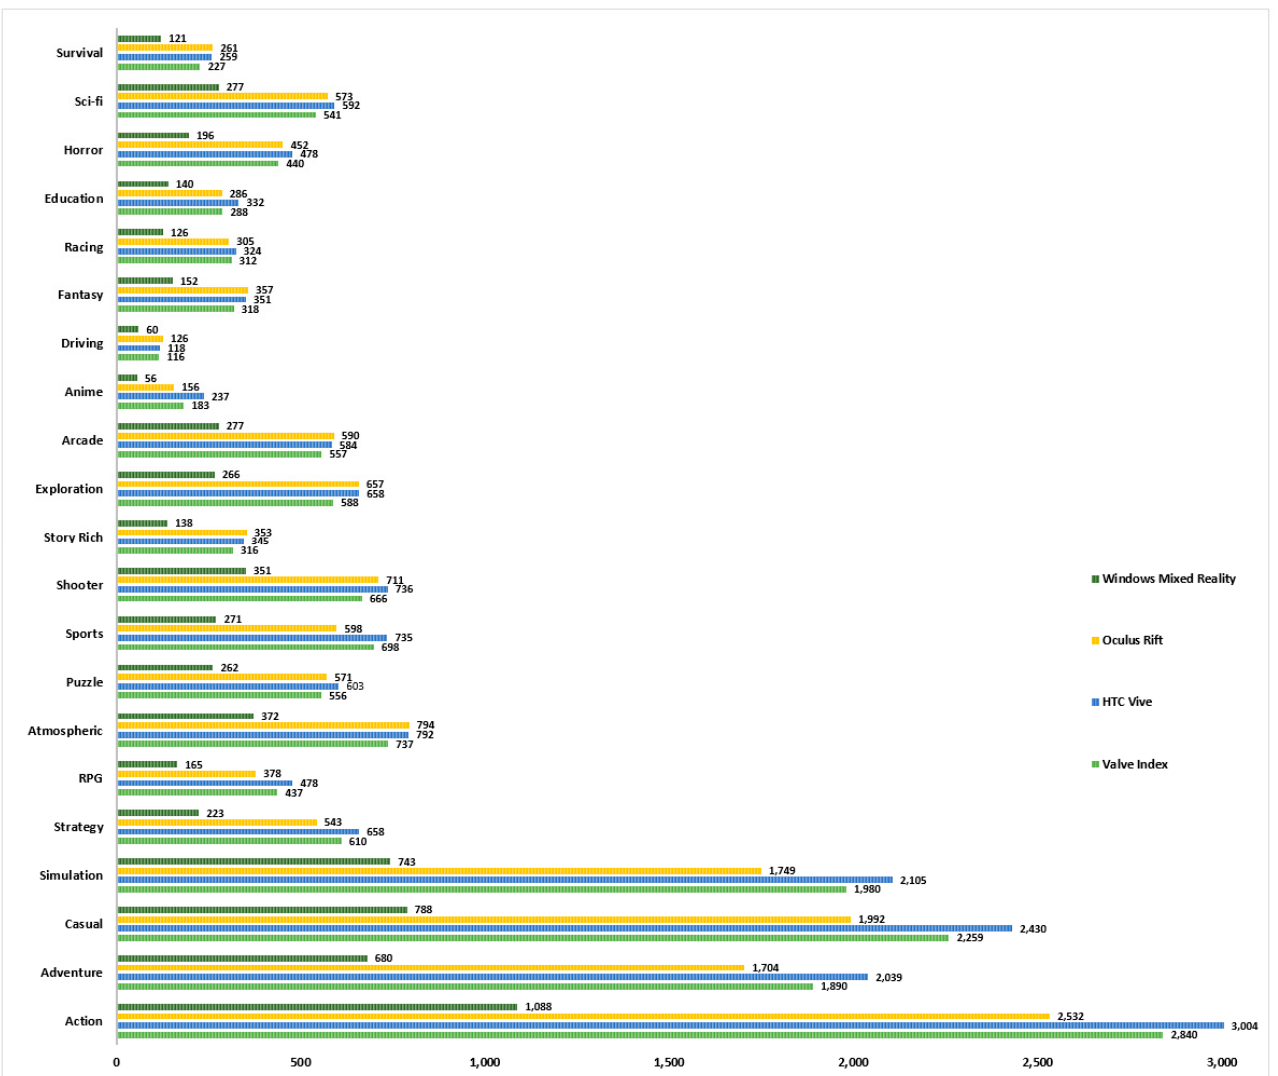
Figure 3. The number of VR applications for a given headset based on the genre on Steam [author’s own study based on data from [35].